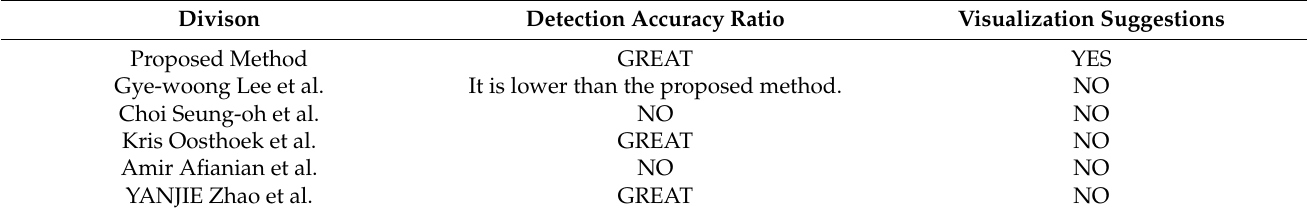
Table 10. Comparison of malicious file detection method using machine learning research